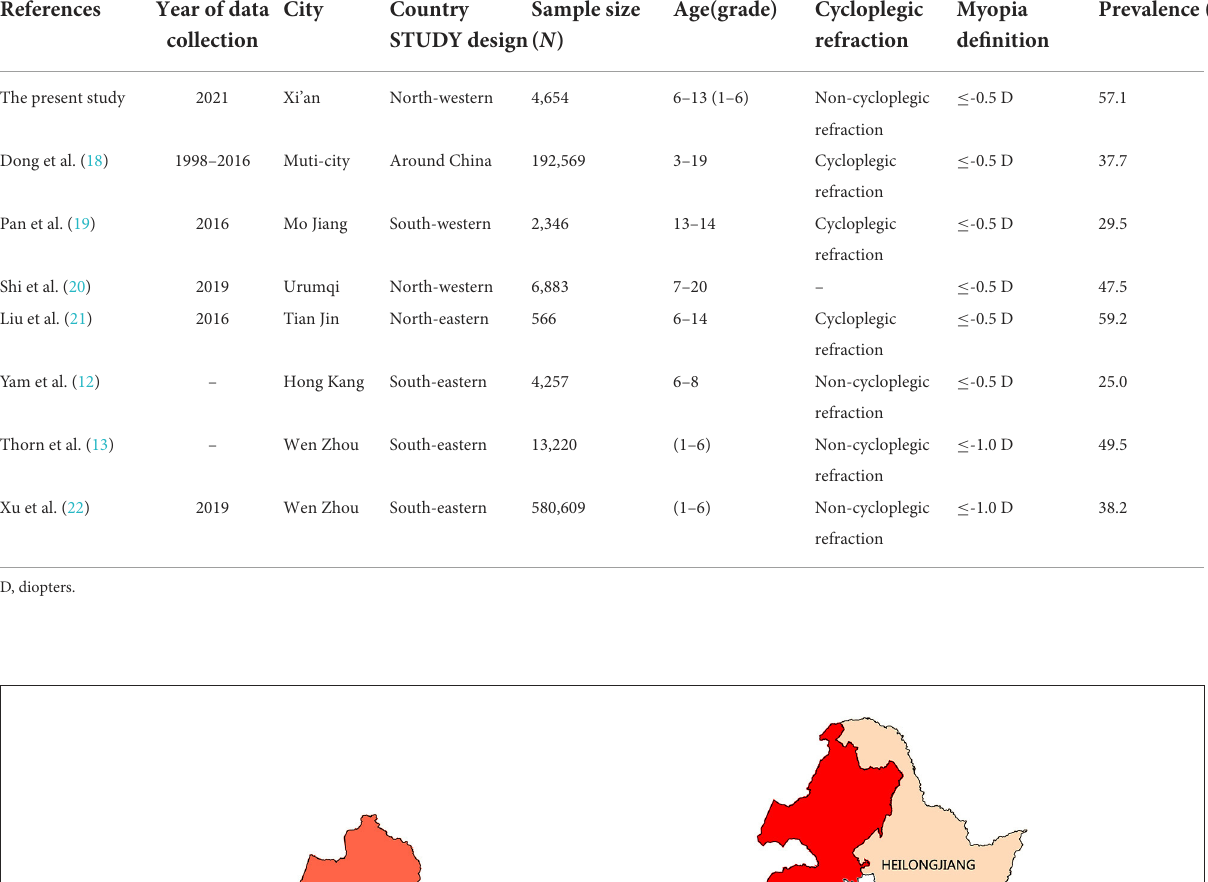
TABLE 6 The prevalence of myopia around China by published